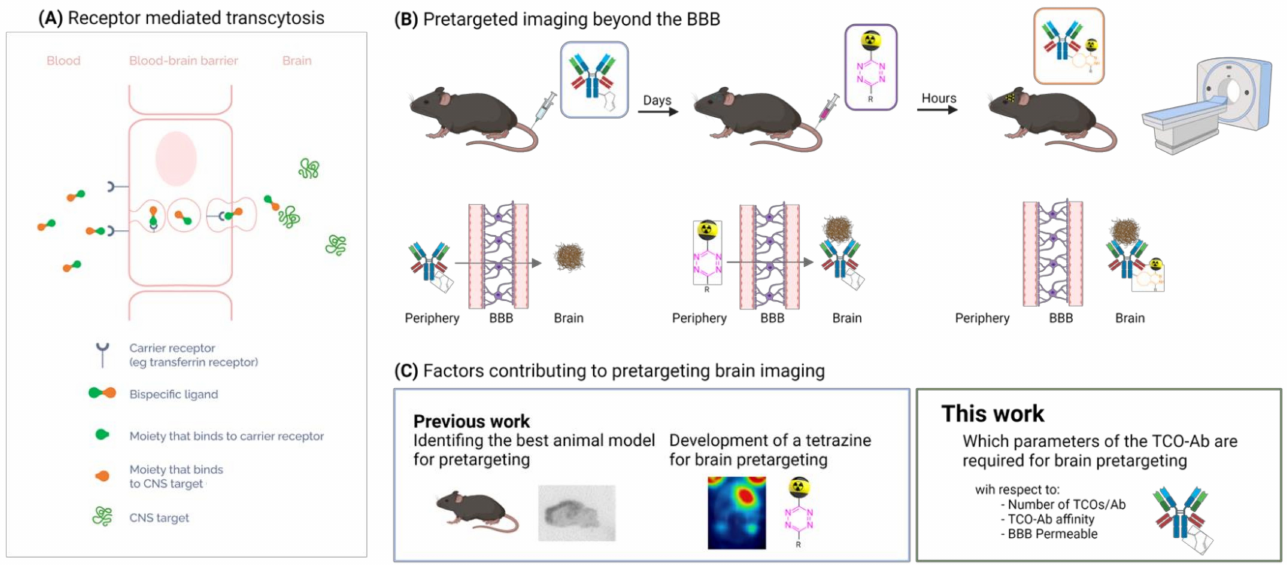
Figure 1. ( A ) An illustration of receptor-mediated transcytosis (RTM). A bispecific ligand binds to its carrier protein and is transported into the brain by transcytosis. ( B ) A schematic overview of pretargeted imaging beyond the BBB. The TCO-Ab is injected first and accumulated at its target within the brain. In a second step, a radiolabeled Tz is administered. This Tz crosses the BBB and reacts with the TCO-Ab. This ligation results in a radiolabeled Ab that can be imaged. ( C ) An overview of the factors contributing to pretargeting in the brain. Previous work describes the identification of animal models and BBB-permeable Tzs. In this work, parameters regarding BBB-permeable TCO-Abs were